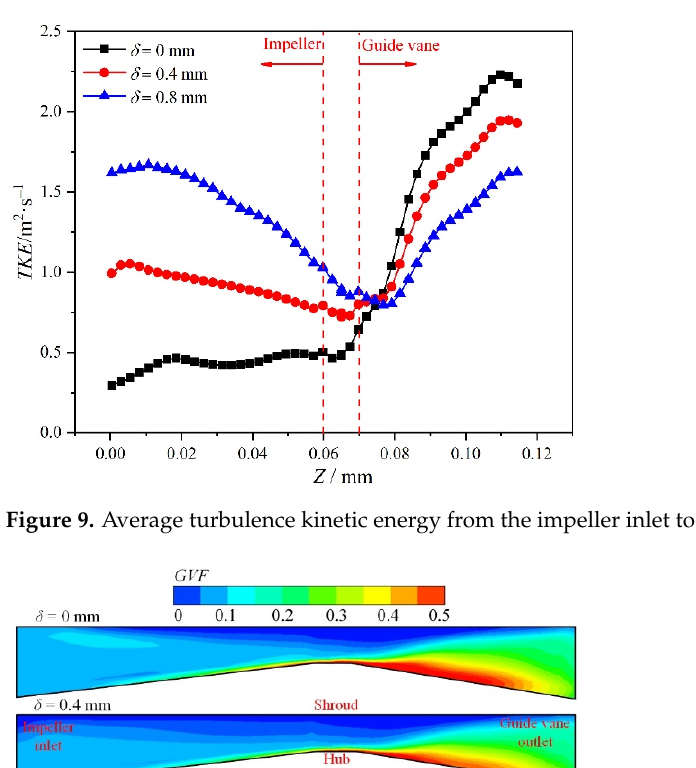
Figure 9. Average turbulence kinetic energy from the impeller inlet to the guide vane outlet.